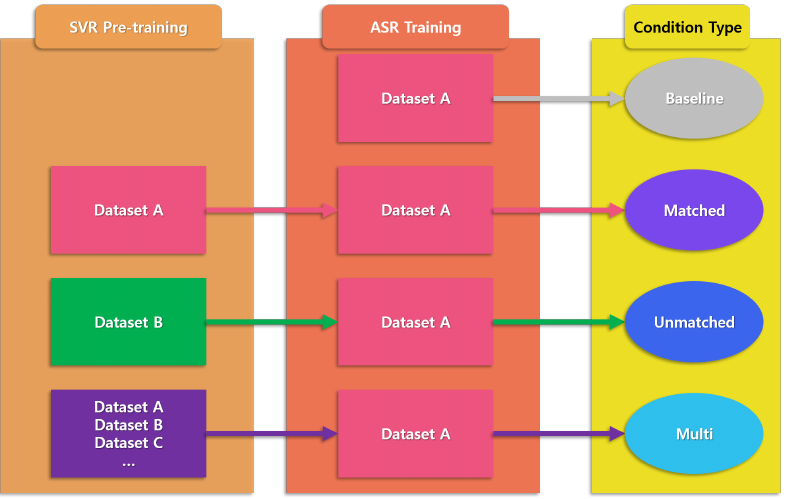
Figure 3. The illustrations of the proposed SVR model learning with unsupervised masking